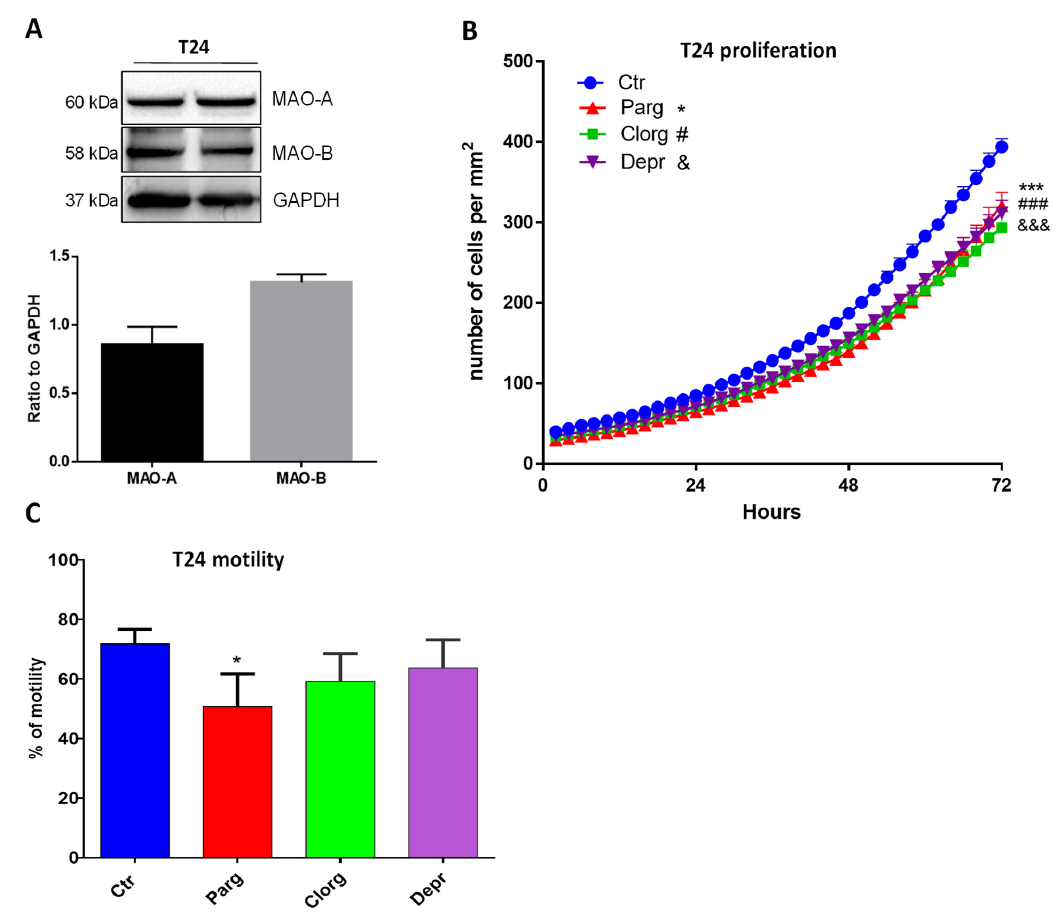
Figure 3. MAO inhibitor effects on proliferation and motility of human T24 cells. ( A ) Protein expression of MAO-A and MAO-B in T24 cells, N = 3. ( B ) Proliferation curve of T24 cells cultured in standard media supplemented or not with different inhibitors (pargyline 10 − 5 M, clorgyline 10 − 6 M, deprenyl 10 − 6 M). The number of cells was automatically counted every 2 h (Incucyte, Sartorius) and compared to Ctrl condition on day 3, N = 4. ( C ) T24 cells cultured in standard media supplemented or not supplemented with different inhibitors (pargyline 10 − 5 M, clorgyline 10 − 6 M, deprenyl 10 − 6 M), were wounded and then re-treated for 24 h. Quantification of images was performed at 24 h. N = 4. * p < 0.05, *** p < 0.001, ### p < 0.001, &&& p < 0.001 compared with Ctr cells. All the values are expressed as mean ±